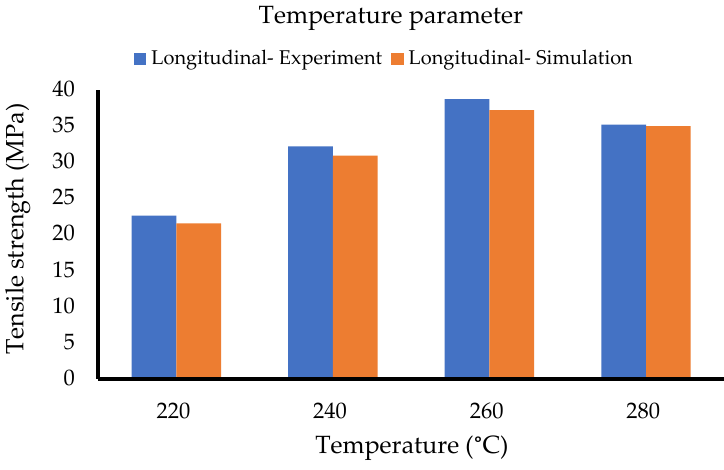
Figure 11. Temperature set (Method 1).